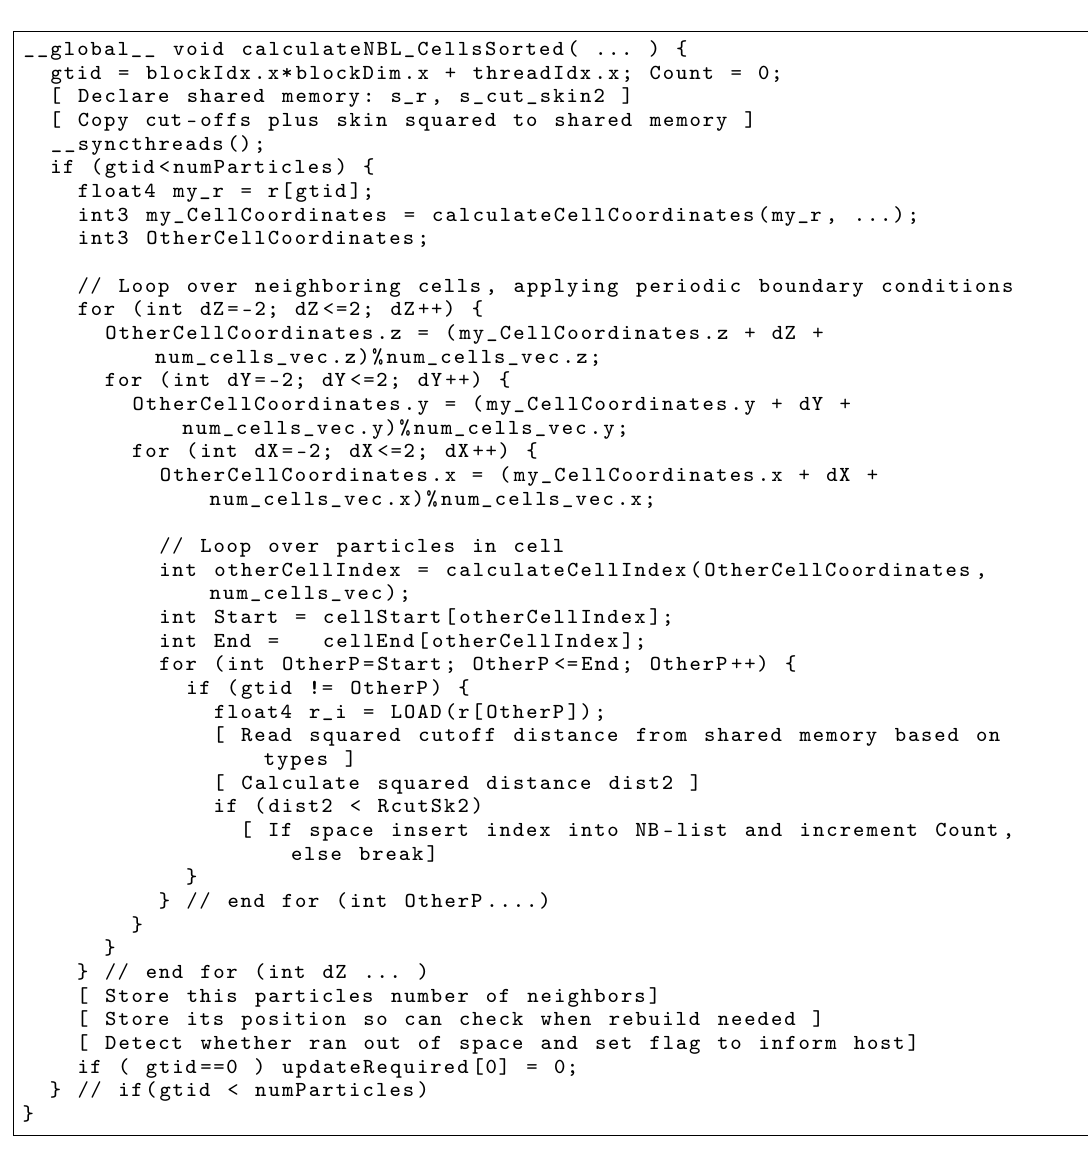
Figure 5: Kernel for order-N neighbor-list generation. calculateCellCoordinates(...) calculates the coordinates of the cell that a particle belongs to. calculateCellIndex(..) calculates the index of a cell given its coordinates. The arrays cellStart and cellEnd contain the indices of the first and last particles, respectively, associated with a given cell. to pick the optimal value of p b